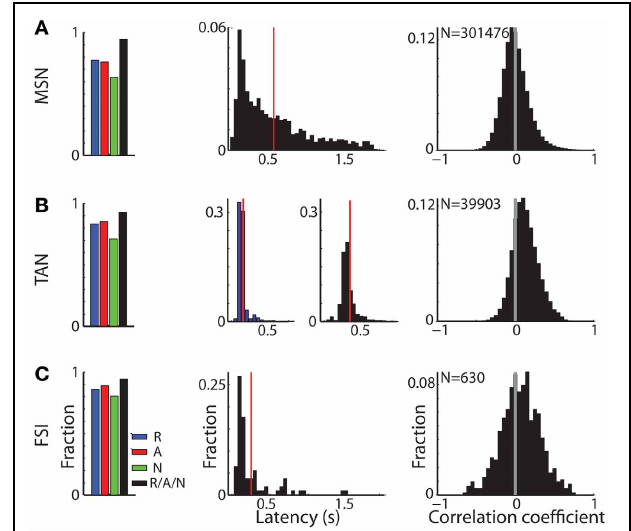
FIGURE 2 | Striatal MSNs, TANs, and FSIs display different firing patterns. (A) MSN discharge pattern. Left subplot: Distributions of the CV of the ISIs of striatal MSN neurons. Abscissa: CV. Ordinate: fraction of cells. Right subplot: Average ± SEM (solid line and envelope) auto cross correlation histogram of MSNs normalized by the average discharge rate and averaged over all cells. N is for number of neurons. (B) TAN discharge pattern. Same conventions as in (A) . (C) FSI discharge pattern. Same conventions as in (A) .